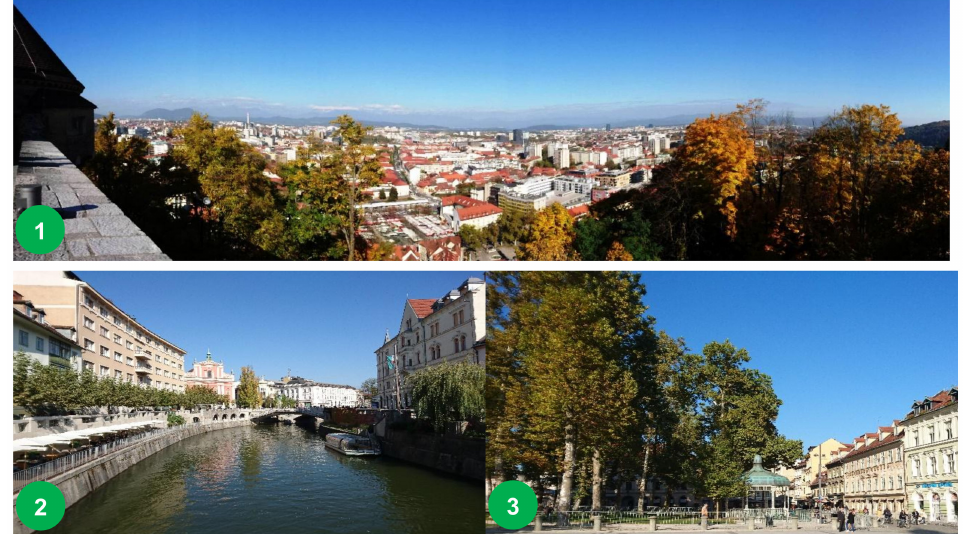
Figure 1. Ljubljana, Slovenia 2016 European Green Capital: ( 1 ) Panoramic view of the city’s vegetation, ( 2 ) Vegetation along canals, ( 3 ) Large trees and canopy cover (Photographs taken by G. T. Cirella, 22 October